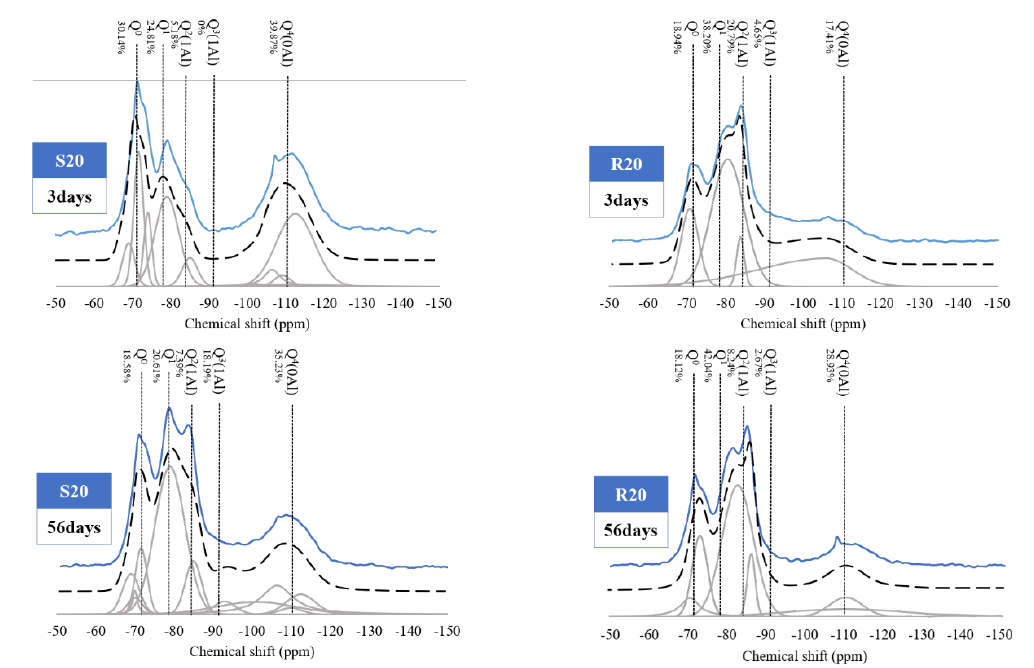
Figure 7. Thermogravimetric analysis (TGA) of samples at the ages of 3 and 56 d (the derivative TG (DTG) and weight reduction curves of the steam curing and room temperature curing specimens are classified according to age, and the combustion materials are selected according to the temper- ature range.).